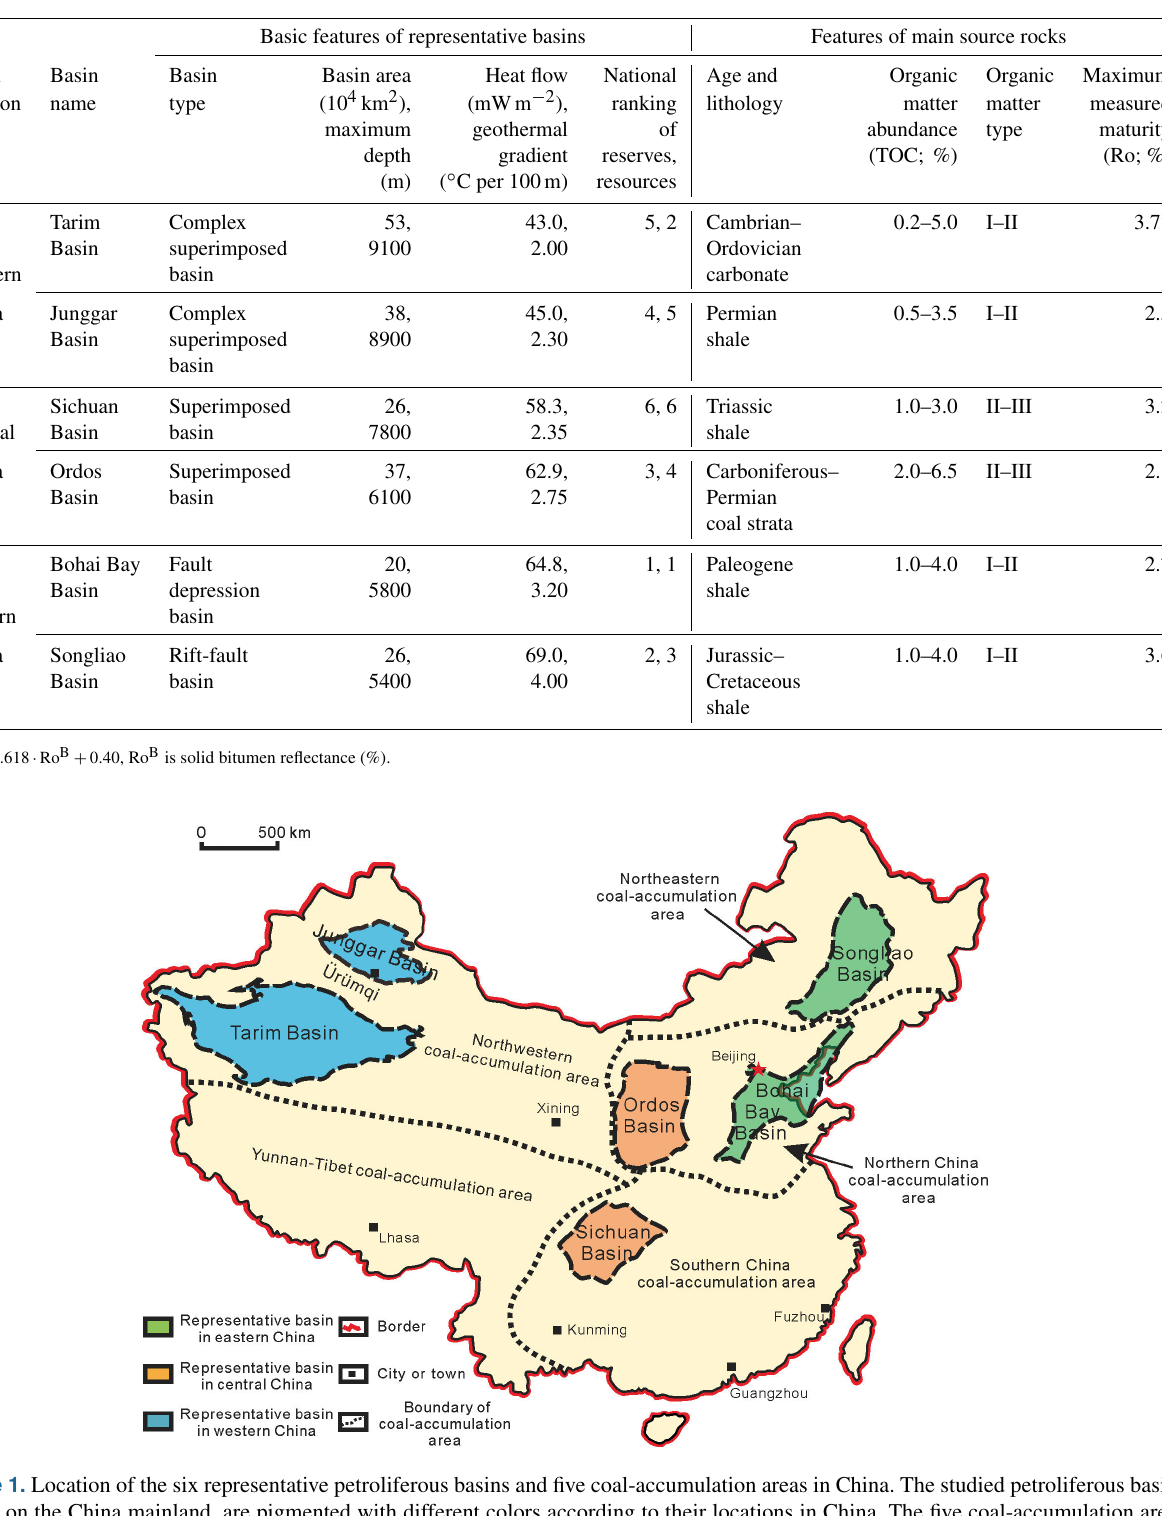
Table 1. Geological and geochemical characteristics of the main source rocks from the six representative petroliferous basins in China.